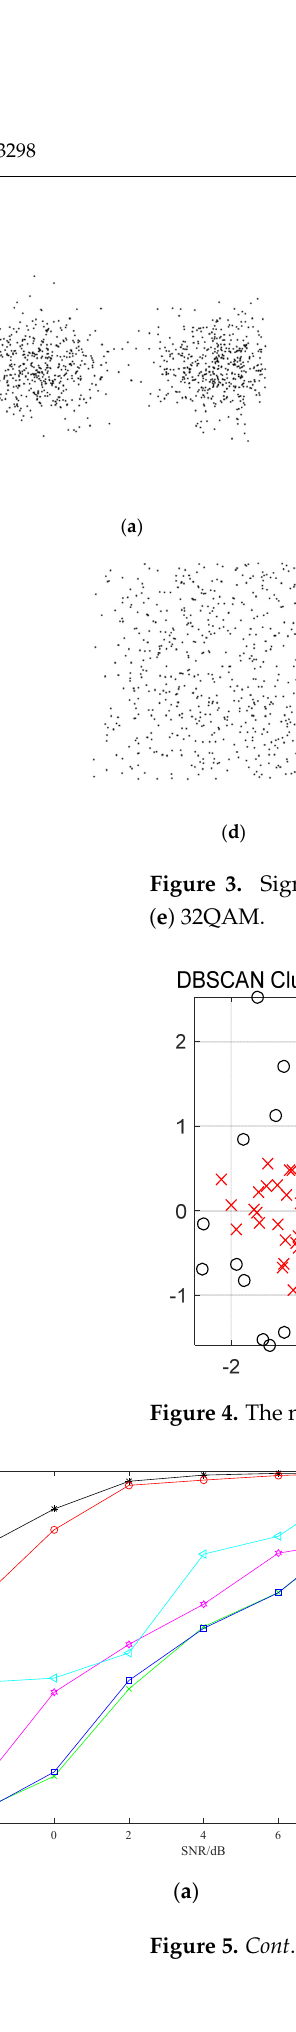
(8) Figure 2. The block diagram of multi-classifier system using SVM. 3. Experimental Results and Analysis